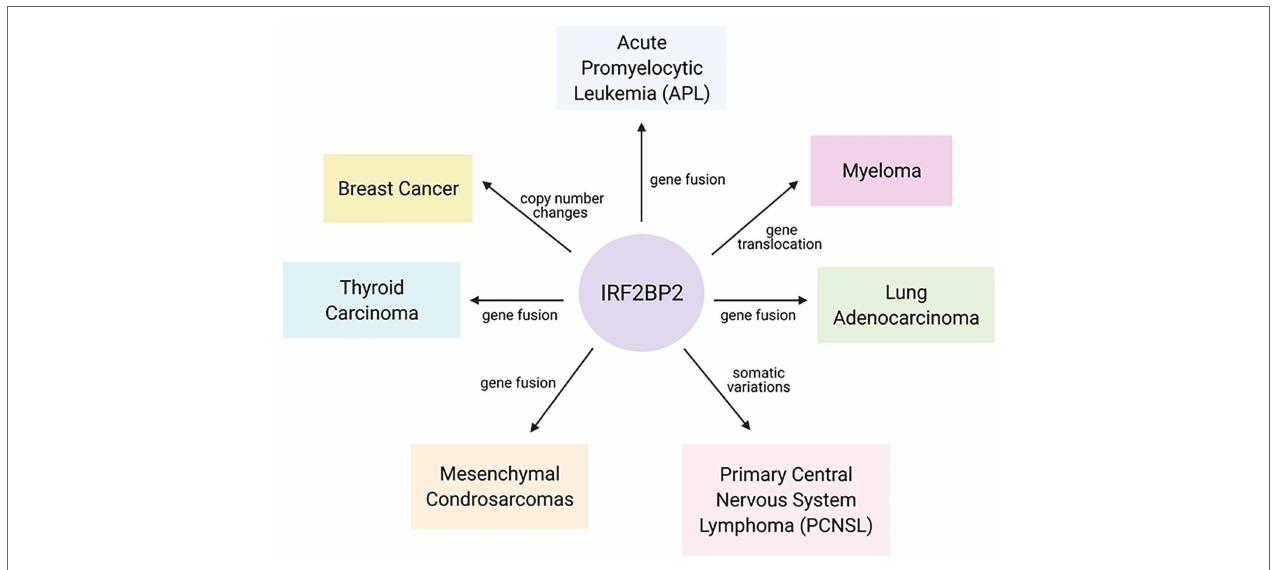
FIGURE 3 | Interferon regulatory factor 2-binding protein 2 in the malignancy of hematopoietic and solid tumors. Gene fusion, copy number changes and mutations in IRF2BP2 coding sequences were found in different kinds of cancer and are linked to an increased probability of cancer